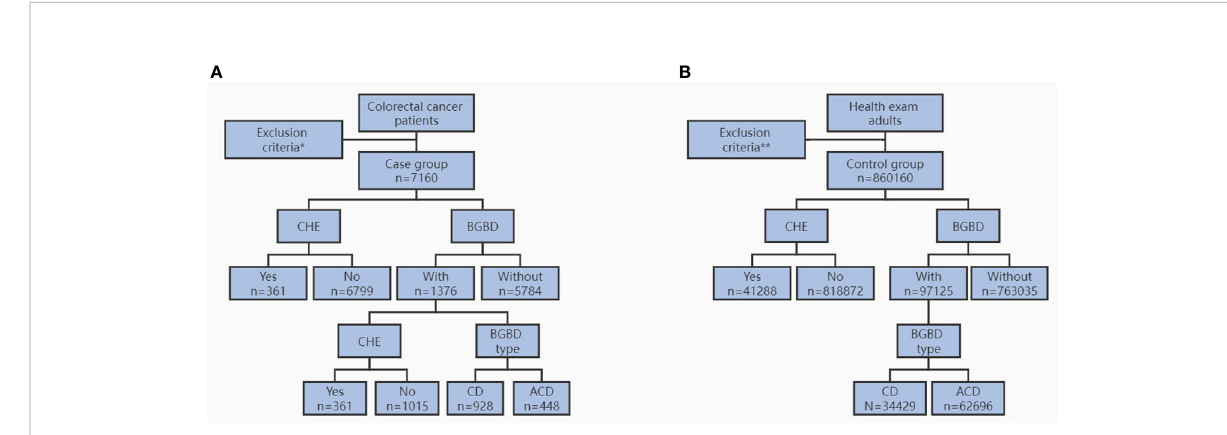
FIGURE 1 Flow diagram for study population of case group (A) and control group (B) . CHE, cholecystectomy. BGBD, benign gallbladder disease. CD, calculous disease. ACD, acalculous disease. * age < 18 years, BMI < 15.0kg/m 2 , multifocal CRC, other cancer, and incomplete data. ** age < 18 years, BMI < 15.0kg/m 2 , any cancer, and incomplete